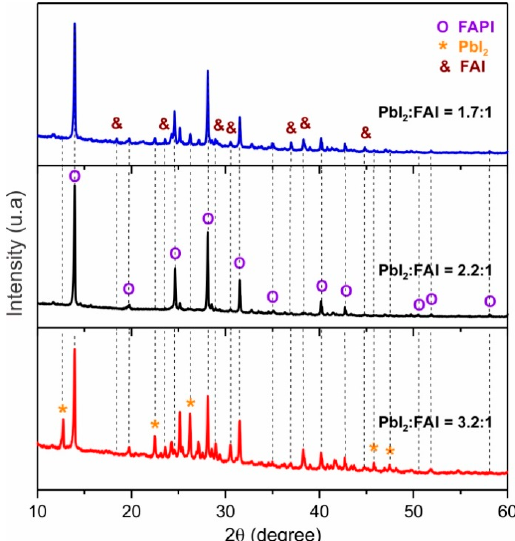
/ FAI thickness 2